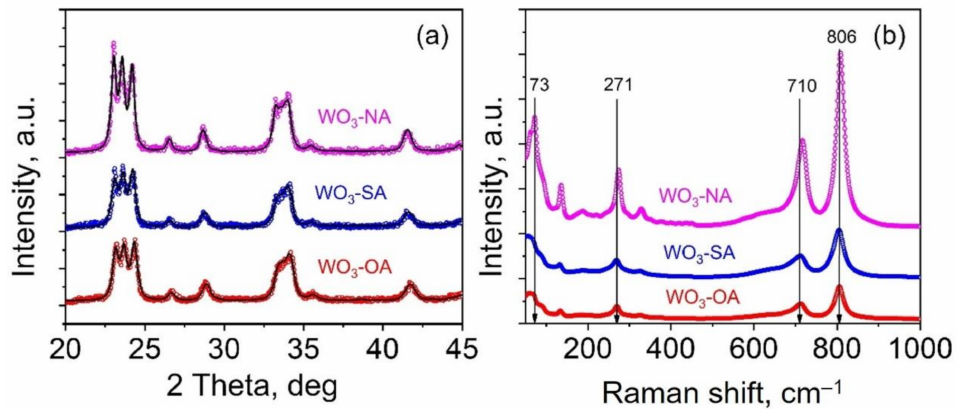
Figure 2. XRD patterns ( a ) and Raman spectra ( b ) of products obtained by electrochemical oxidation of tungsten under pulse alternating current using oxalic acid (WO 3 -OA), sulfuric acid (WO 3 -SA), and nitric acid (WO 3 -NA). The measured diffraction data are shown by circles, and the calculated are shown by solid lines in